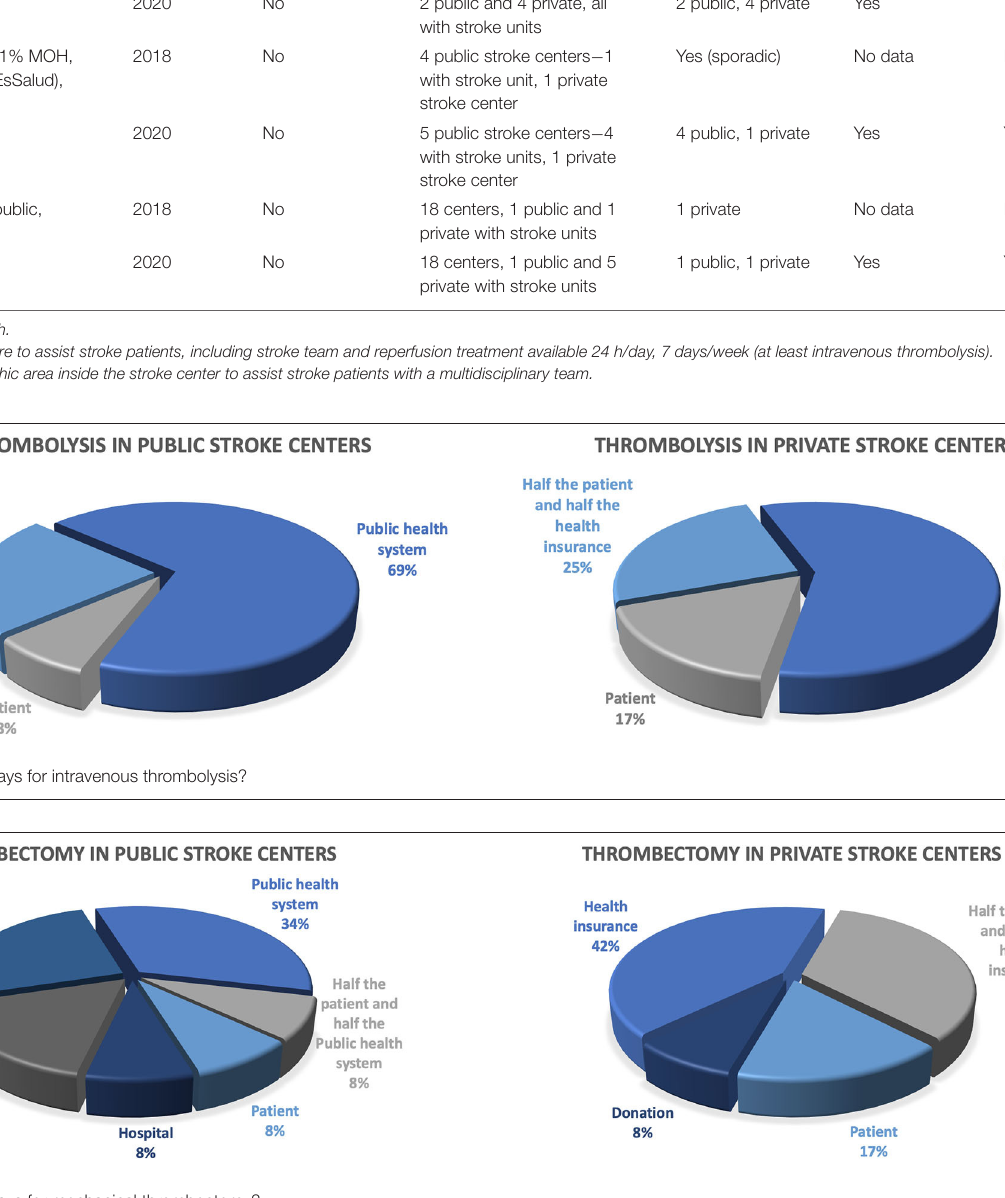
The awareness campaigns launched by the World Stroke Organization 8 in 2006 have being increasingly used every